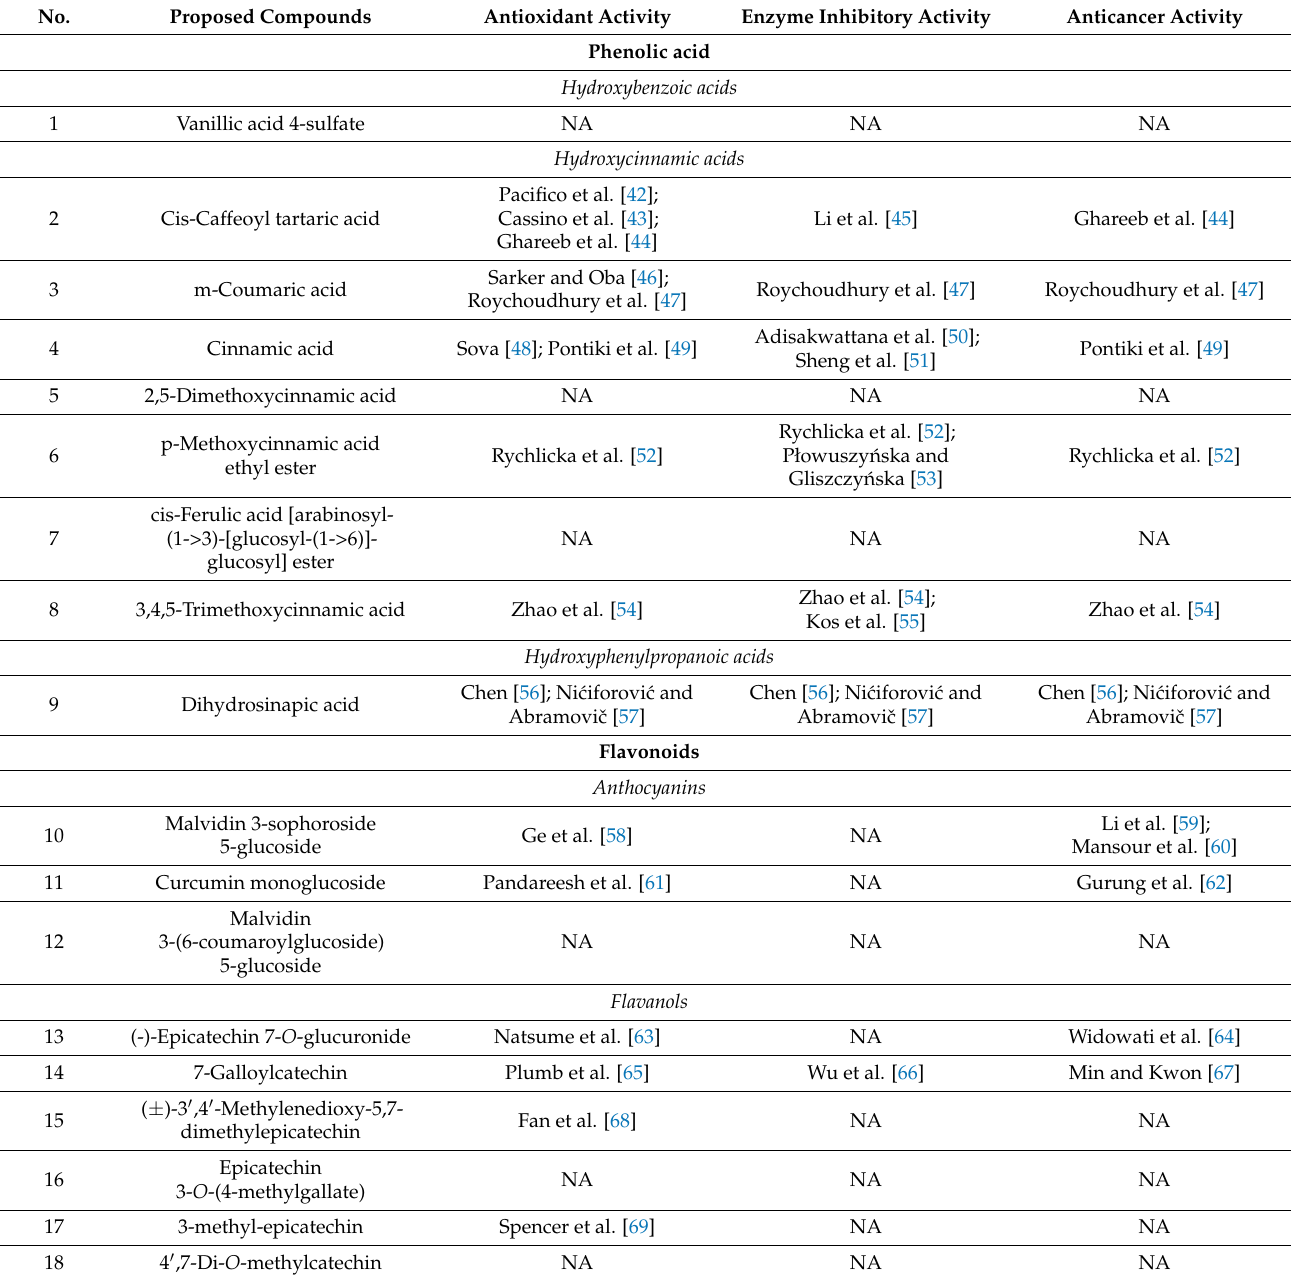
Table 3. Comparison of identified compounds with previous studies on